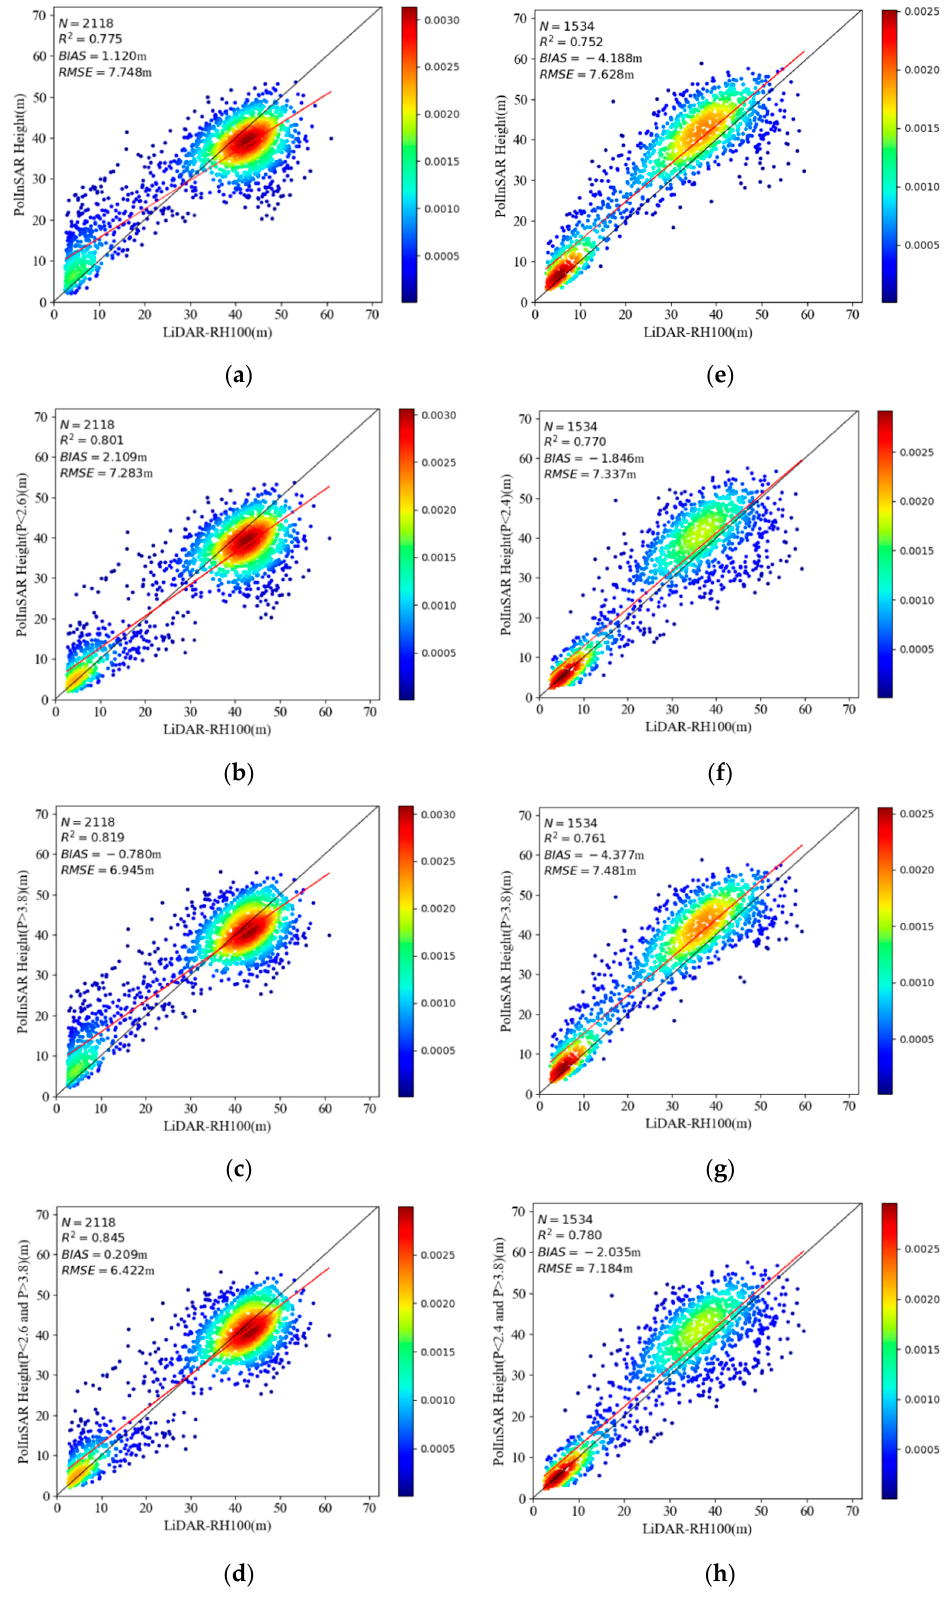
Figure 14. Scatter plots showing the validation of results with P RF as a threshold correction in the Lope test area ( b – d ) and the Pongara test area ( f – h ). ( a , e ) are the results of the RVoG model before correction for the Lope and Pongara test areas, respectively.